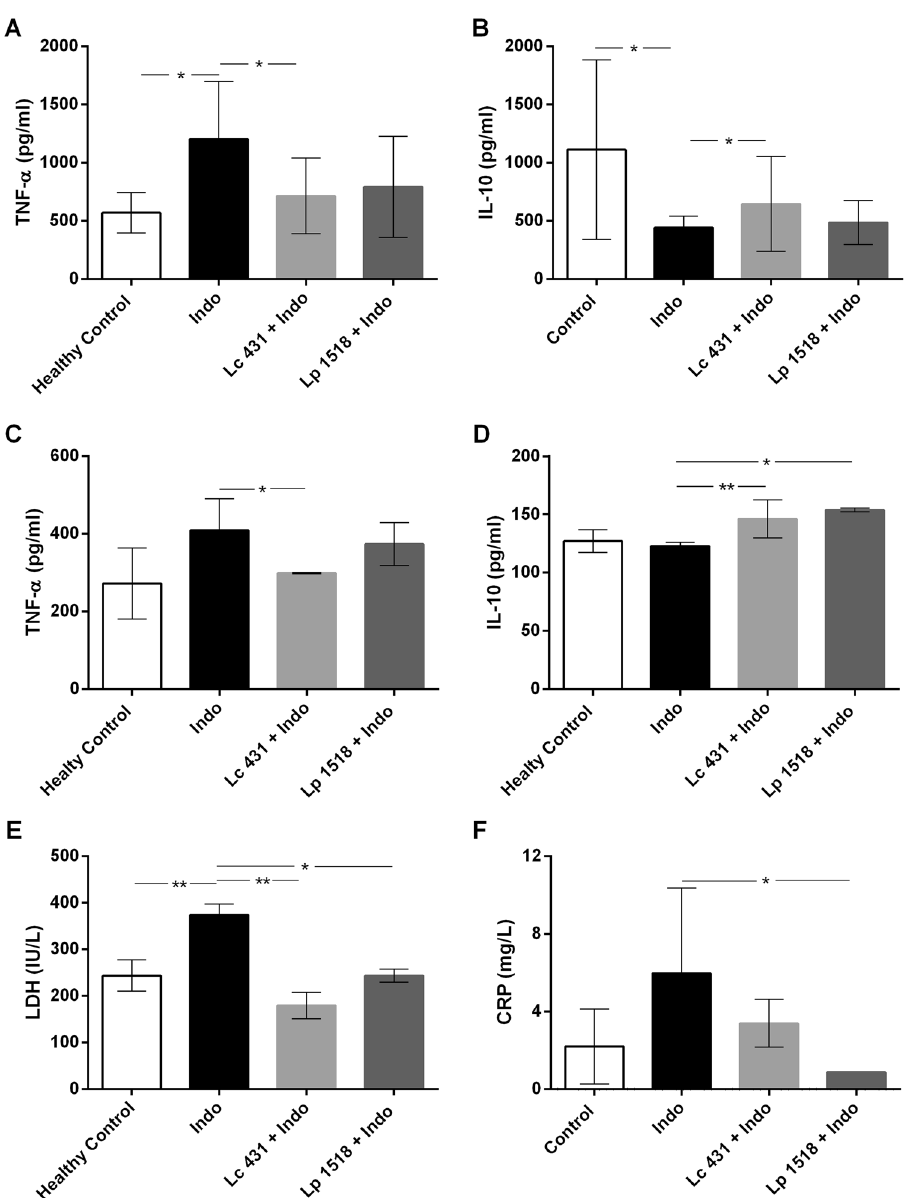
Figure 6. Cytokine secretion in the intestinal microenvironment of indomethacin-treated mice fed probiotics. TNF-α ( A , C ) and IL-10 ( B , D ) were determined in the ( A , B ) intestinal fluids and ( C , B ) supernatant of the epithelial cell culture from healthy control mice and animals with an intestine inflammation process receiving a conventional diet (Indo) or oral supplementation with probiotics (Lc 431 + Indo and Lp 1518 + Indo). Samples were assayed in duplicate by Capture ELISA. The results are representative of 3 independent experiments (n = 6). The line at the top of the bars indicates comparison between the 2 groups. * p < 0.05 and ** p <